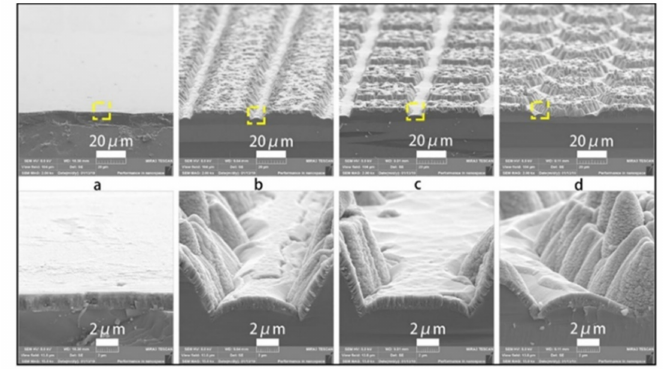
Figure 8. SEM images of ( a ) planar TiO 2 film; ( b ) grating-structured TiO 2 film; ( c ) square-structured TiO 2 film; ( d ) hexagon-structured TiO 2 film. All figures are reprinted from [89], with permission from Elsevier,